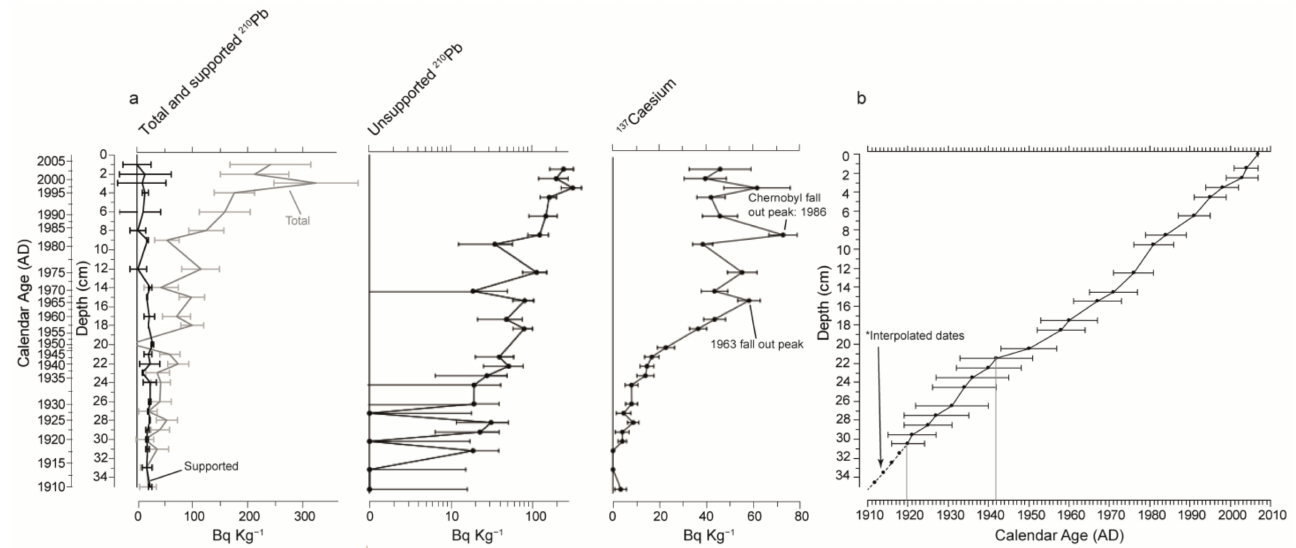
Figure 2. ( a ) Depth profiles of 210 Pb and 137 Cs for Kilen. ( b ) 210 Pb and 137 Cs based age–depth model for the Kilen Kajak core (collected in 2007). * The lowermost dates of the Kajak profile are extrapolated based on the average accumulation of 0.5 cm yr − 1 from 1920–1942 (grey line), as the sedimentation rate changes little over this period. A potential hiatus means that this dating profile has not been matched with the 14 C dates available for the longer (Holocene) sedimentary sequence available for this site [44,54,55]. The sediment core was collected from a water depth of 390